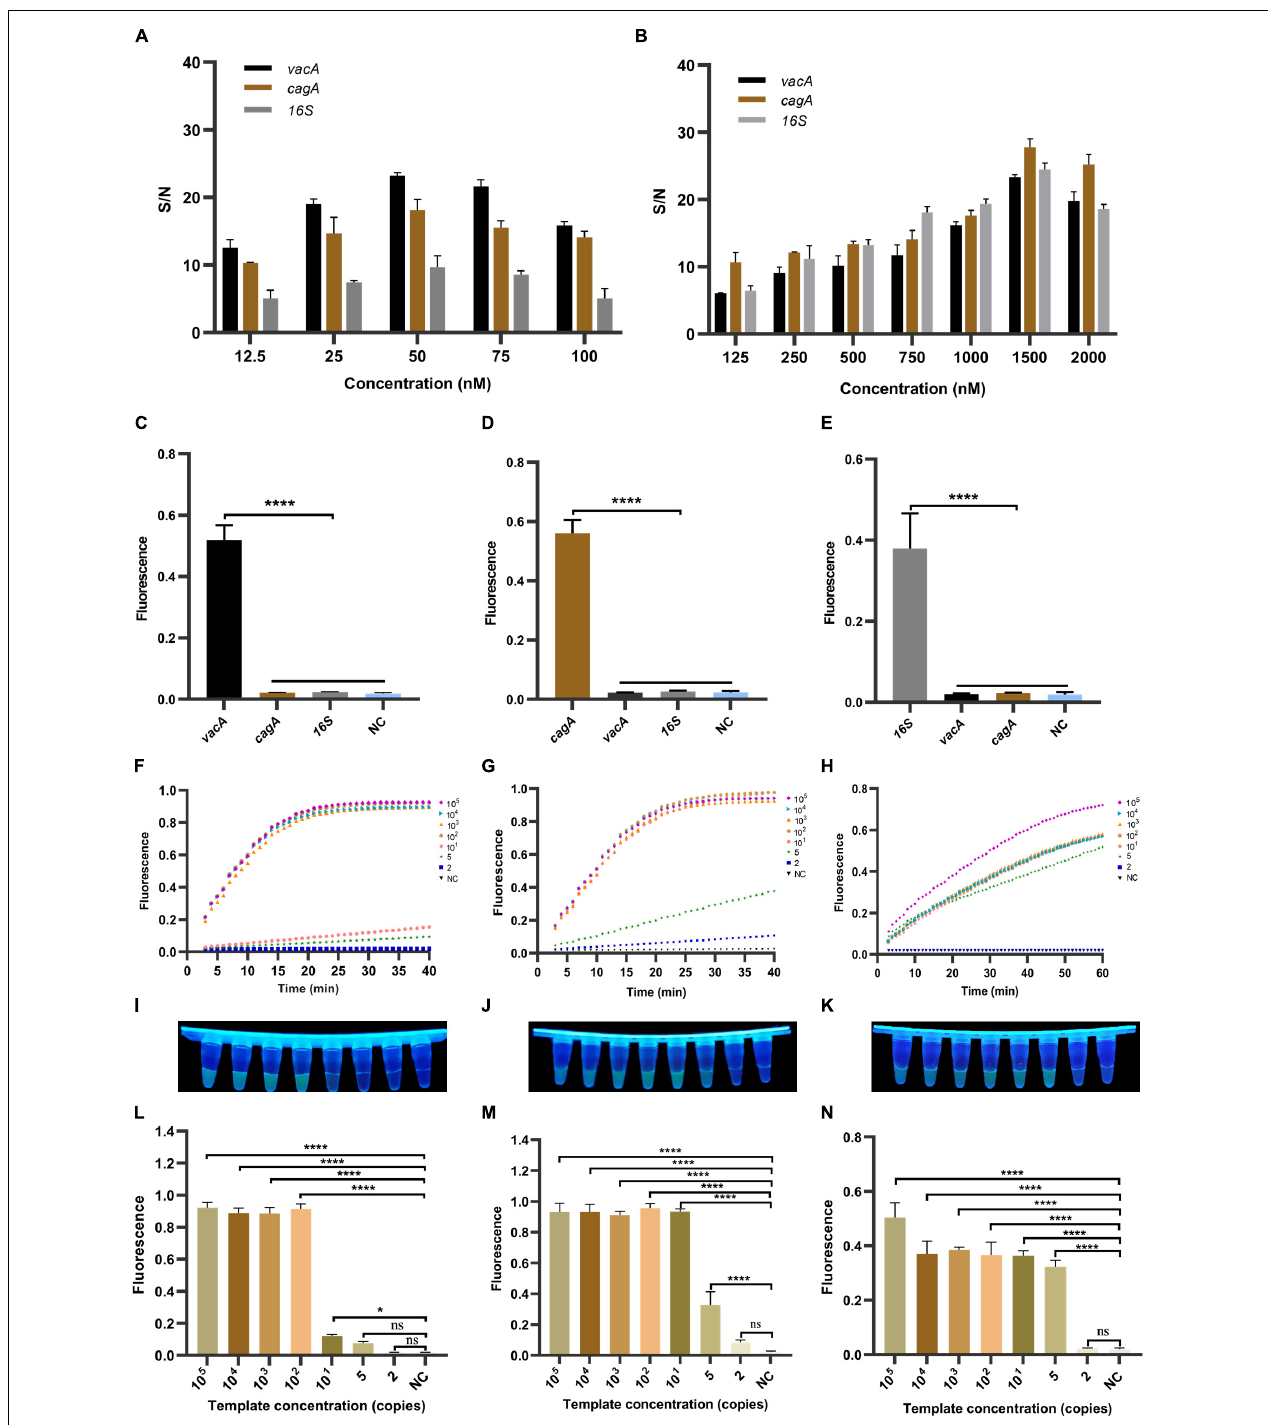
FIGURE 3 | The establishment and optimization of the RPA-CRISPR method for H. pylori . RPA-CRISPR method signals depend on the concentration of (A) crRNA and (B) ssDNA-reporter. For the selectivity of (C) vacA , (D) cagA , and (E) 16SrDNA , the positive samples were all diluted templates (10 5 copies/ µ l). The fluorescence curves of (F) vacA , (G) cagA , and (H) 16SrDNA generated by the Light Cycler 480 fluorescence detection system at each dilution within 30 min. The fluorescence intensity values with diluted templates of (I) vacA , (J) cagA , and (K) 16SrDNA are detected by UV device at 30 min, and the corresponding fluorescence values with diluted templates of (L) vacA , (M) cagA, and (N) 16SrDNA are quantified by the Light Cycler 480 fluorescence detection system at 30 min. Negative controls (NC) were replaced with nuclease-free water, and the data were expressed in mean ± SD of the three sets of replicated experiments (ns: p > 0.05; * p < 0.05; **** p <